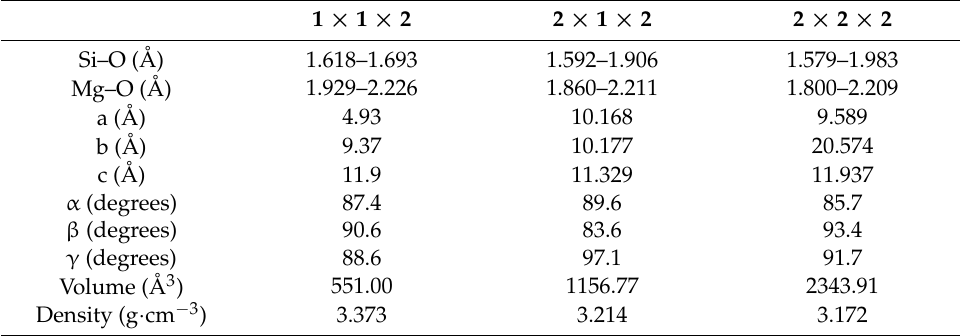
Table 6. B3LYP-optimized bond distance ranges and cell parameters of the 1 × 1 × 2, 2 × 1 × 2, and 2 × 2 × 2 Mg 2 SiO 4 bulk structures. Volumes and densities are also shown.